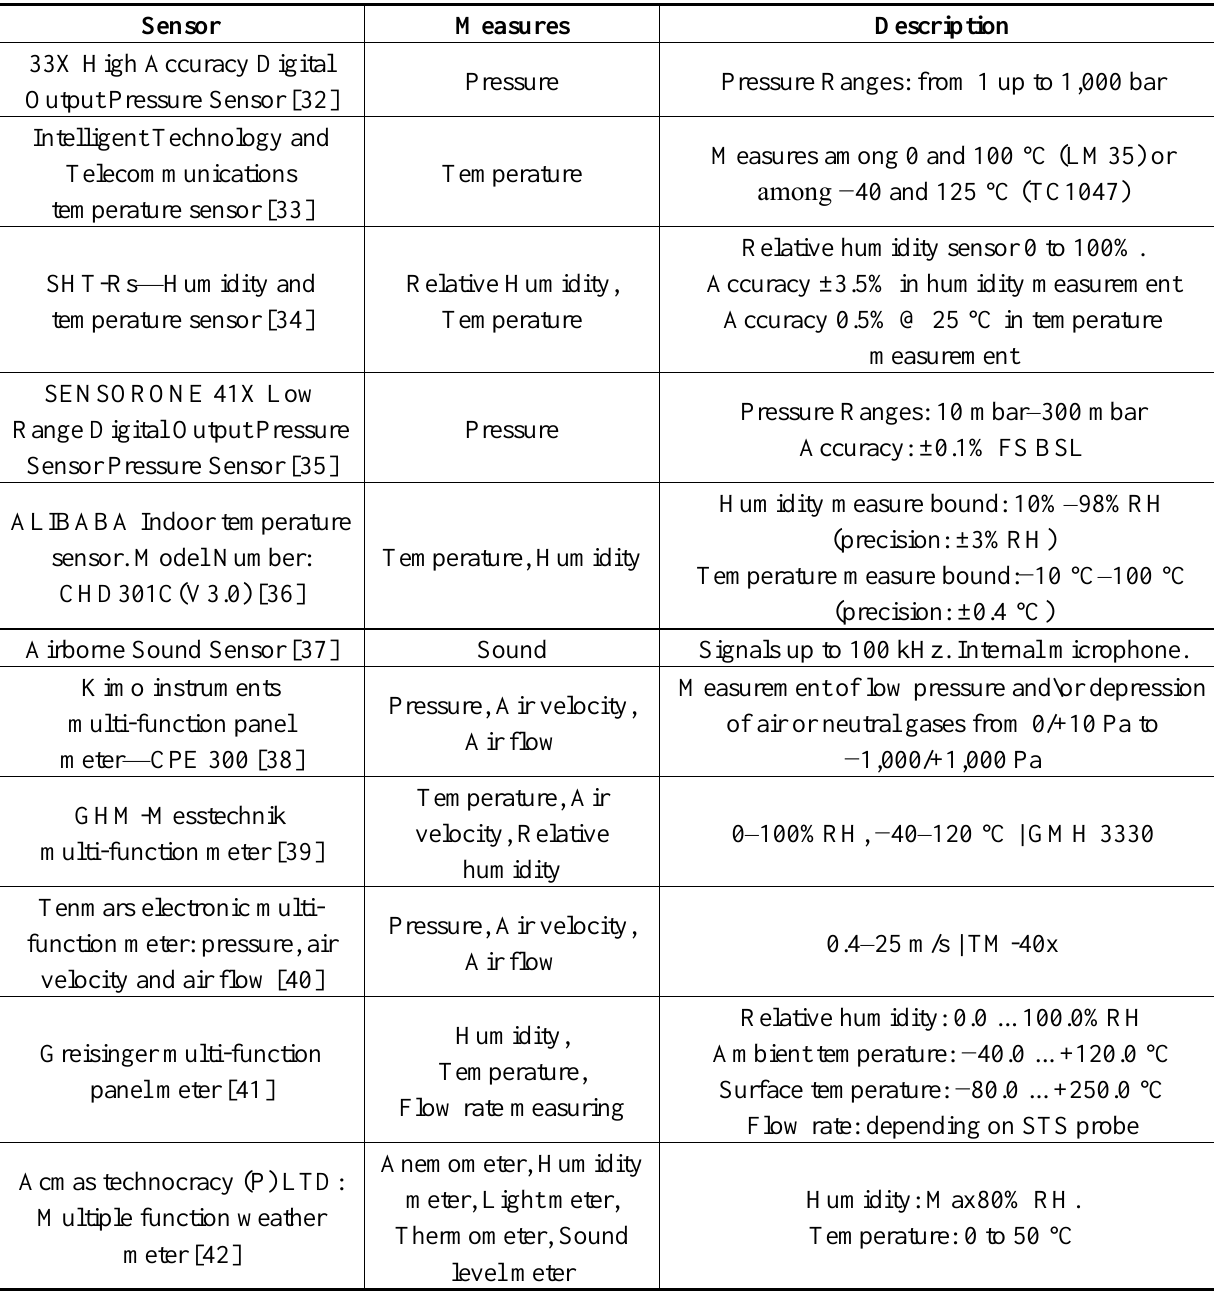
Table 1. Comparative of RS232